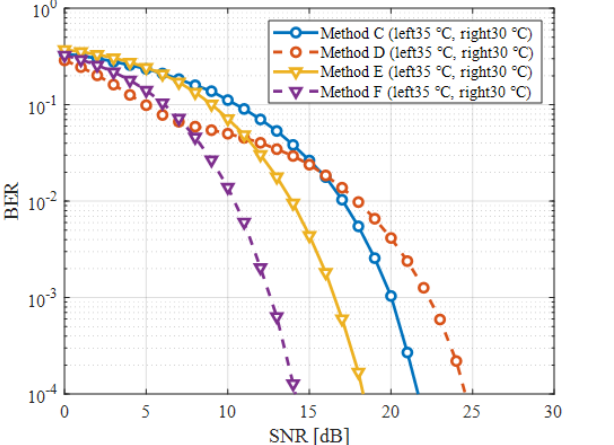
Figure 13. BER characteristics when the left region is 35 °C and the right region is 30 °C.